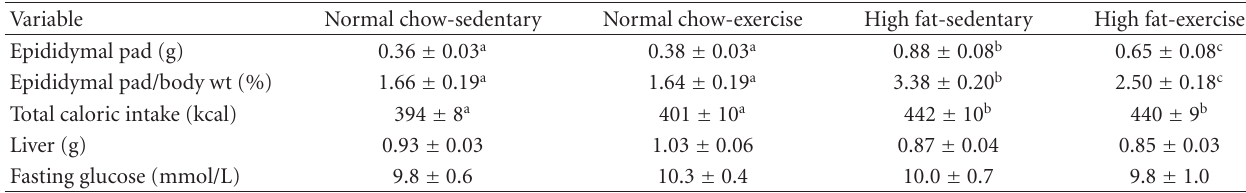
Table 1: Descriptive